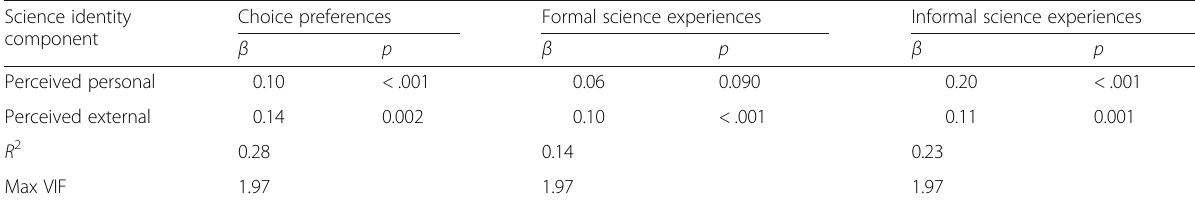
Table 6 Multiple regressions comparing perceived personal vs. perceived external science identity factors. All models include fascination, values, and competency beliefs as covariates Science identity component